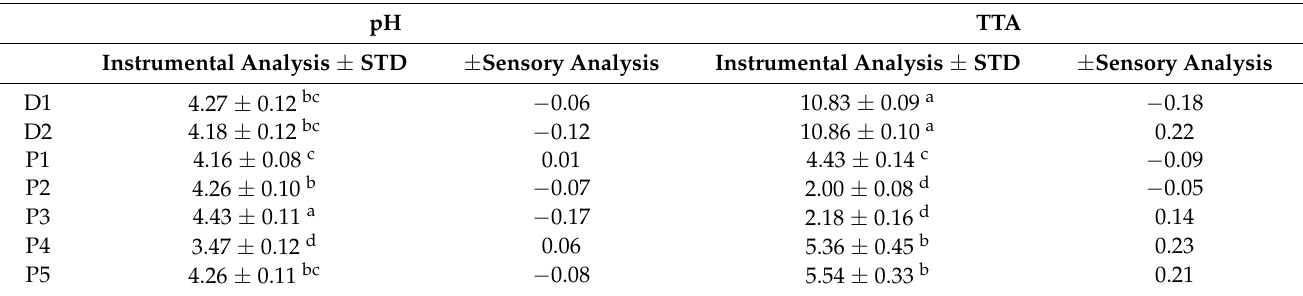
Table 3. pH and TTA of all the samples in the instrumental analysis ( ± standard deviation) and difference to the samples in the sensory analysis. Superscript letters indicate statistical difference between the samples, in the same column ( p < 0.05).